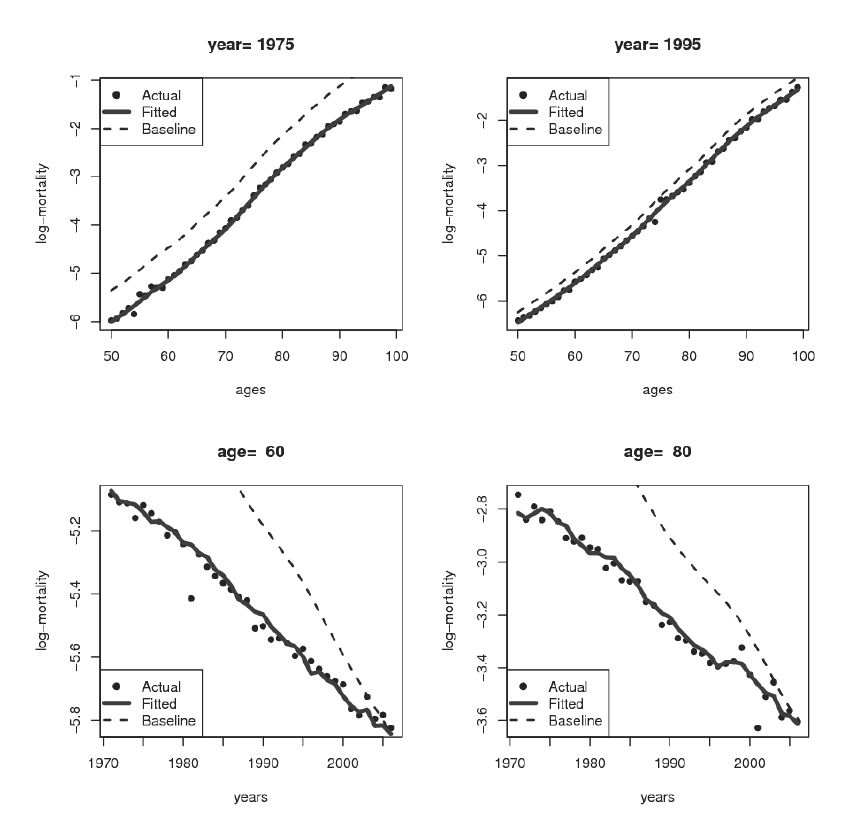
Figura 9 – Observed and fitted mortality rates for selected years and ages. Ip = H and Ic = m 1-4 . Italy,